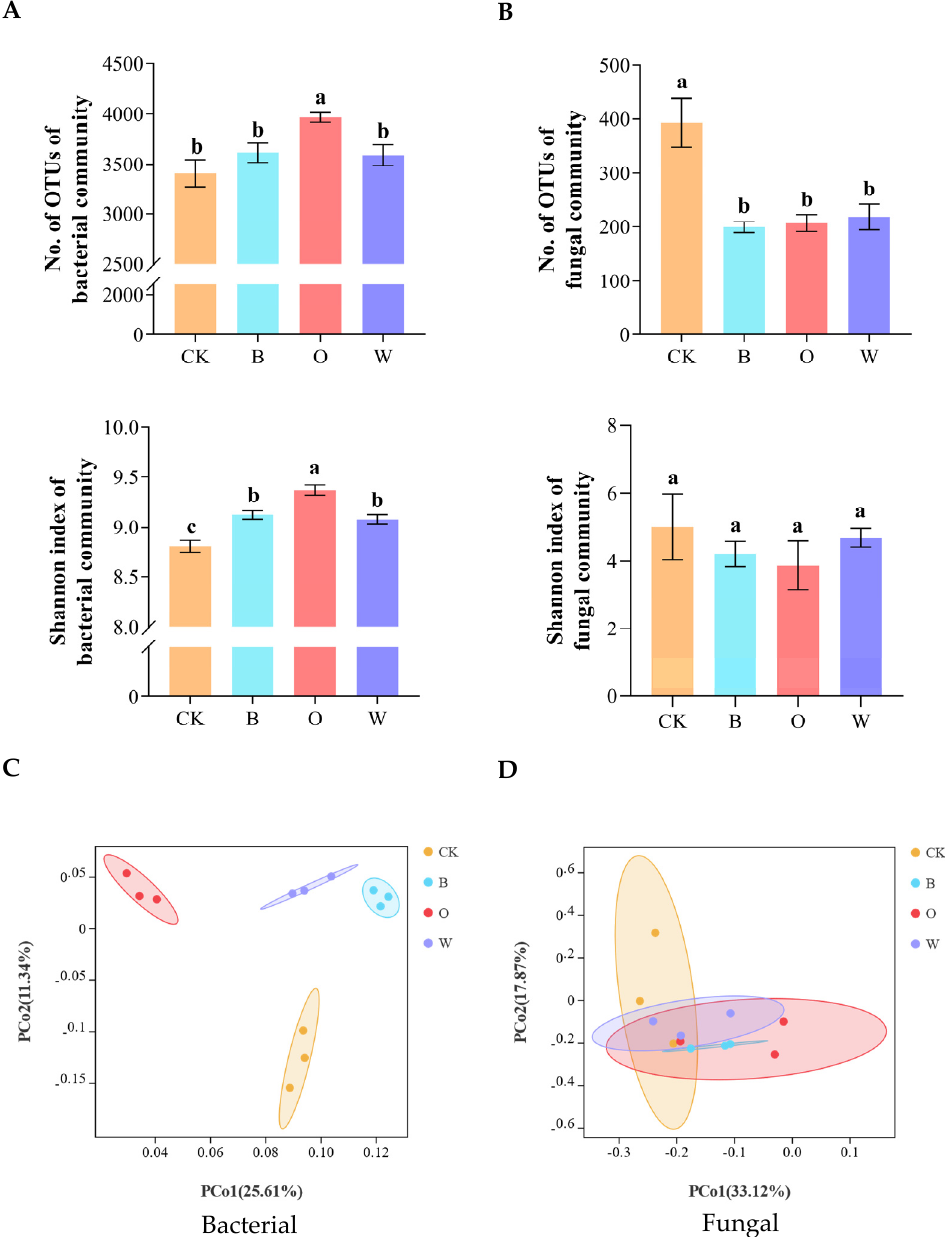
Figure 4. Alpha ( A ) and beta ( C ) diversities of soil bacterial and alpha ( B ) and beta ( D ) diversities of soil fungal communities. Beta diversities based on Bray Curtis distance dissimilarity were visualized by principal component analyses. OTUs were delineated at 97% sequence similarity. CK represents Chinese cabbage continuous cropping; B, O, and W represent bean, potato onion and wheat rotation respectively. Different letters are significantly different ( p < 0.05, Tukey’s HSD test).